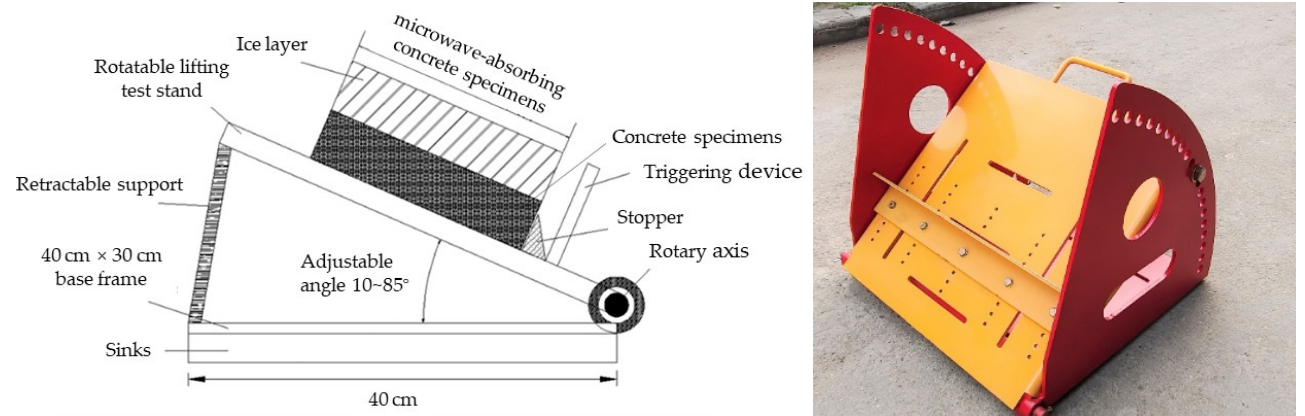
Figure 4. Design diagram of the new device for testing the efficiency of microwave deicing and the physical device.